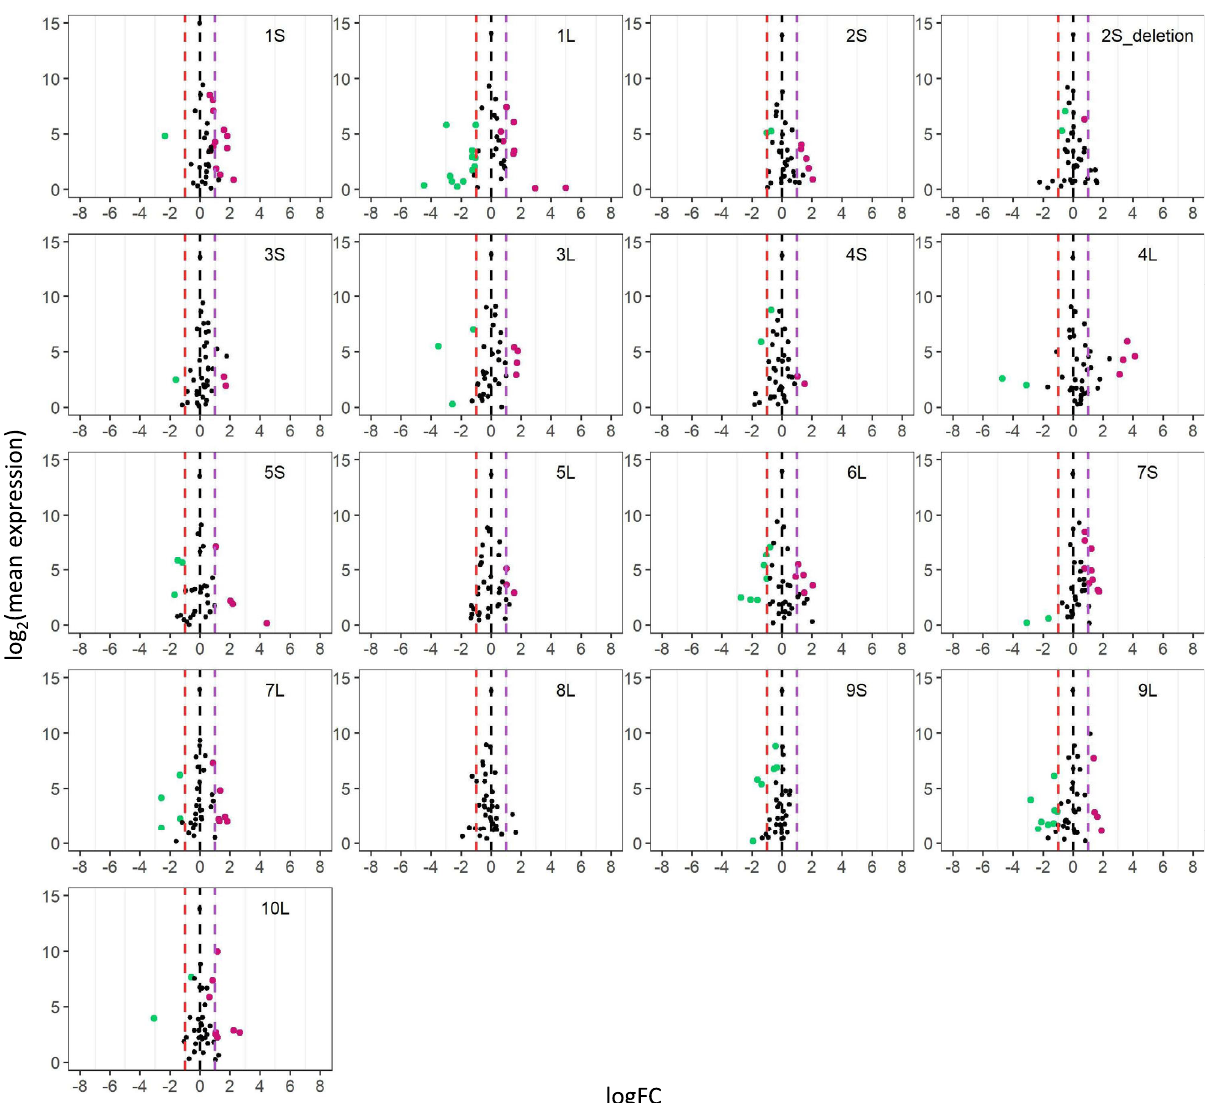
Fig. 5 Scatter plots of trans MIRNA expression in each disomy compared with haploids (h2D/h1D). Analysis was conducted as described in Fig. 2. An FC of 0.5 represents the inverse ratio of MIRNA expression in trans , whereas 2.0 represents a positive modulation. These FC values are demarcated with labeled vertical lines in red (0.5), black (0), and purple (2.0). Source data are provided in Supplementary Data 4.